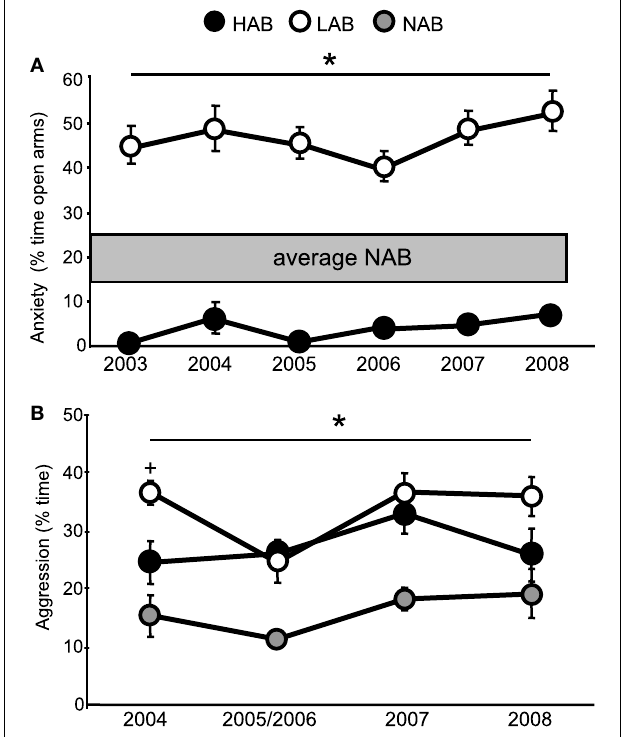
FIGURE 1 | (A) Anxiety-related behaviour on the elevated plus-maze in 9-week-old HAB and LAB rats between 2003 and 2008; * p < 0.05 LAB vs. HAB rats (2003–2008); (B) Aggressive behaviour during the RI test in 16- to 22-week-old male HAB, LAB, and NAB rats between 2004 and 2008. * p < 0.05 NAB vs. HAB (2005–2007) and LAB (2004–2008), + p < 0.05 LAB vs. HAB. Data are presented as mean ±